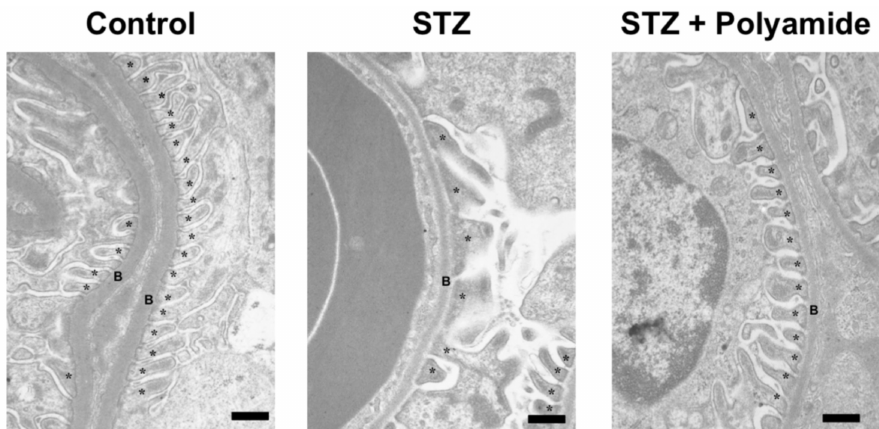
Figure 8. Electron microscopic findings of kidney from control rats, STZ diabetic rats and STZ diabetic rats with pyrrole-imidazole (PI) polyamide targeting TGF- β 1. Diabetes was induced in male Wistar rats by single intraperitoneal injection of 60 mg / kg body weight of STZ. Control rats were intraperitoneally injected with 1 mL of 0.1% acetic acid. Five milligrams of PI polyamide targeting TGF- β 1 polyamide dissolved in 1 mL of 0.1% acetic acid was intraperitoneally injected twice a week for 3 months, and then the rats were sacrificed to removes their kidneys. The ultrastructure of the podocytes was observed under transmission electron microscopy. Scale bar indicates 1 µ m. B–basement membrane,